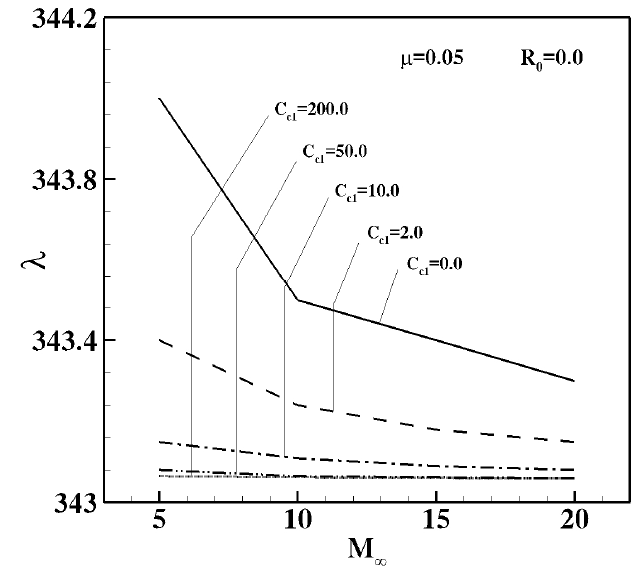
Figure 21. Variation curve of critical dynamic pressure with freestream Mach number for bifurcation of panel under different inertial resistances.